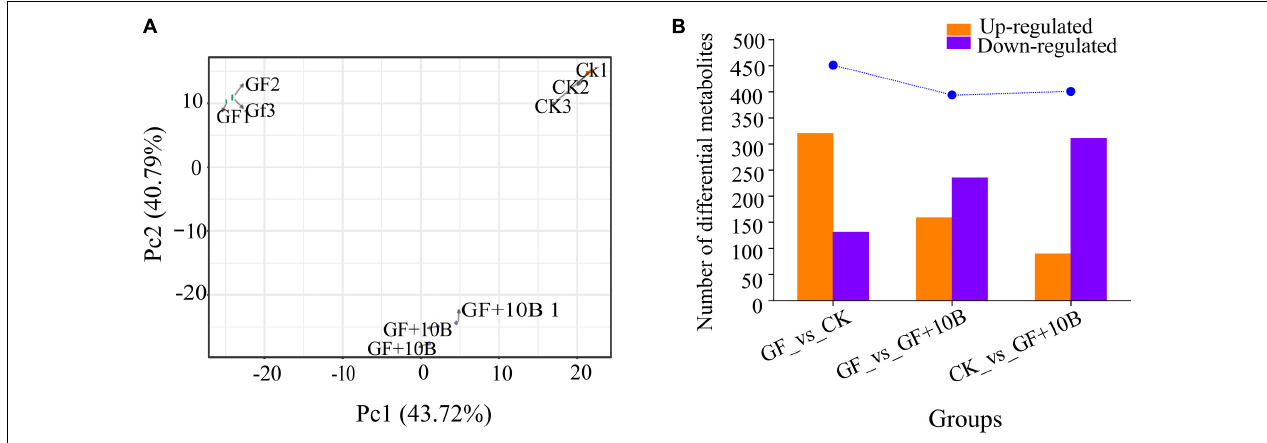
FIGURE 6 | (A) Principal component analysis of the detected metabolites in the BSFL with three biological replicates. (B) Number of differentially accumulated metabolites (DAMs) of BSFL under different rearing conditions. GF, germ-free BSFL fed on sterile food waste; GF + 10B, germ-free BSFL fed on sterile food and 10B; CK, natural BSFL fed on sterile food